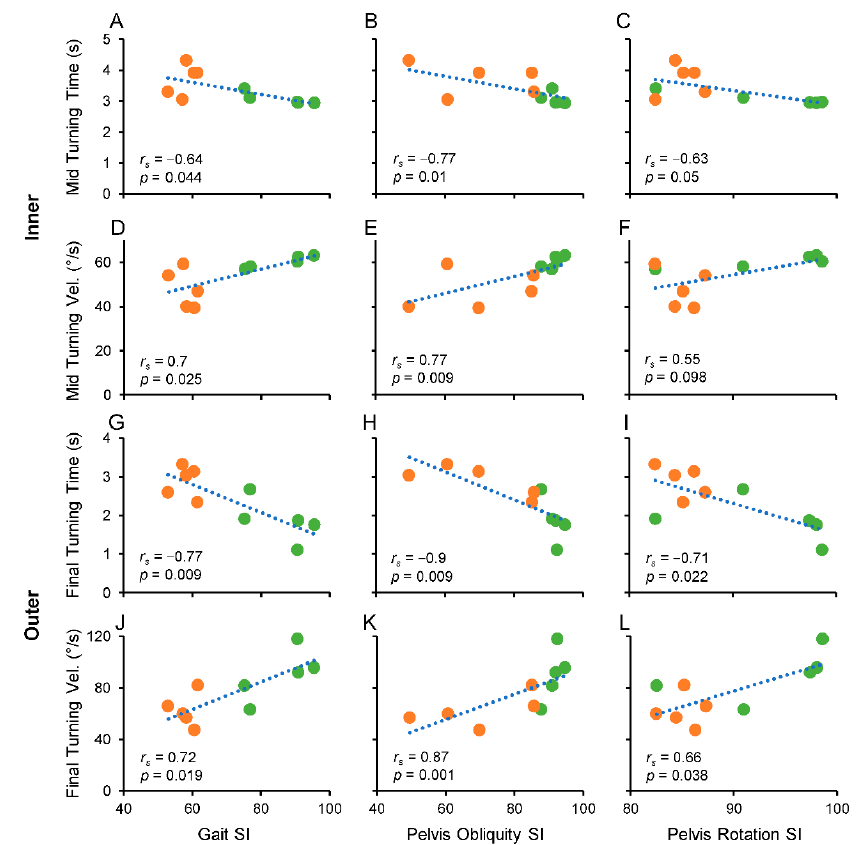
Figure 6. Spearman’s correlation analysis between symmetry index and mid- and final turning time and velocity. Symmetry indexes of gait cycle, pelvis obliquity, and pelvis rotation were correlated with mid-turning time and velocity, when the amputated limb was in inner position ( A – F ), and with final turning time and velocity, when the amputated limb was in outer position ( G – L ). Abbreviation and symbol: r s , Spearman’s Rho coefficient; p , level of significance; orange circles, TF; green circles, TT.